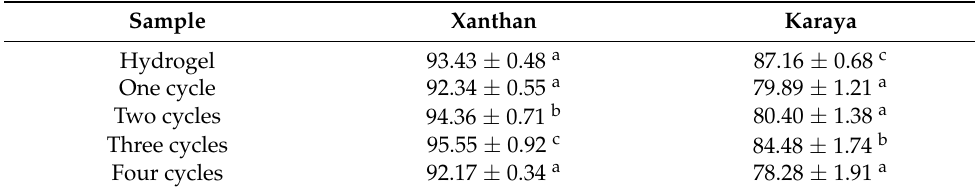
Table 1. Structural order percentage of the hydro- and cryogels.